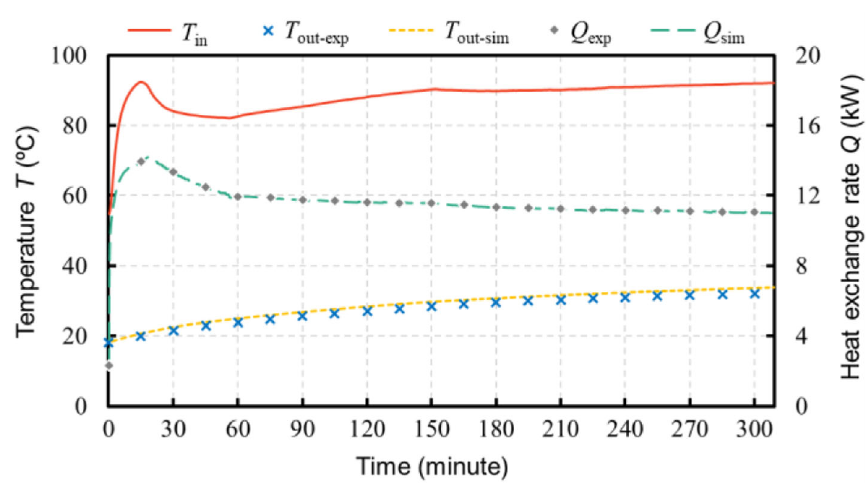
Fig. 24 Model simulation results